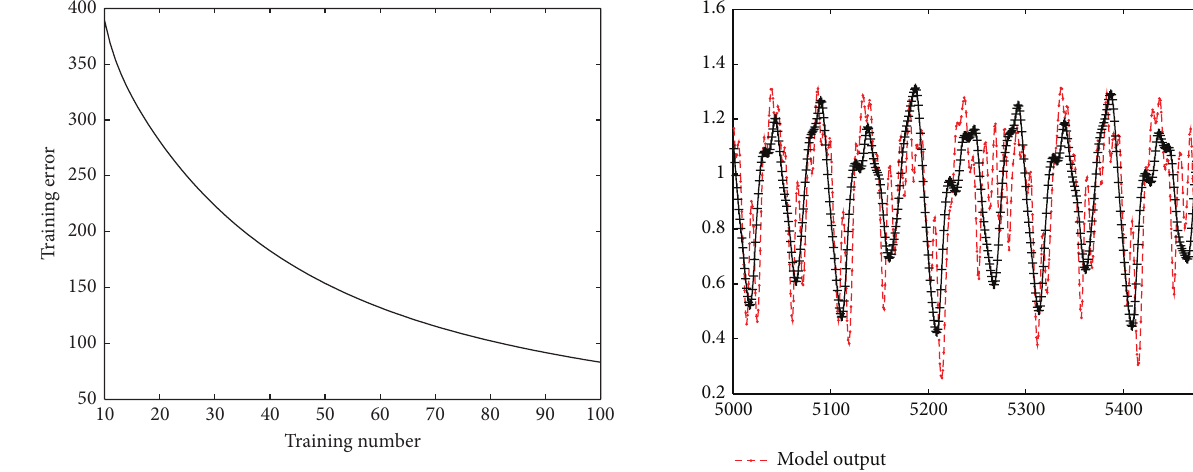
Figure 3: The GDA learning curve of the error function.